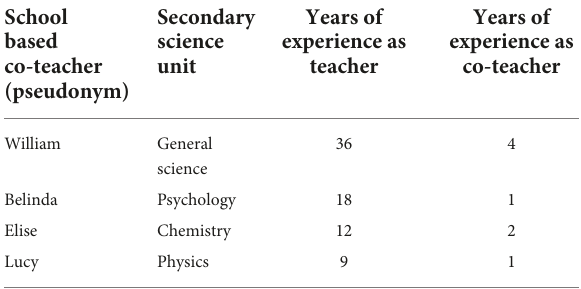
TABLE 1 School based co-teachers experience and science